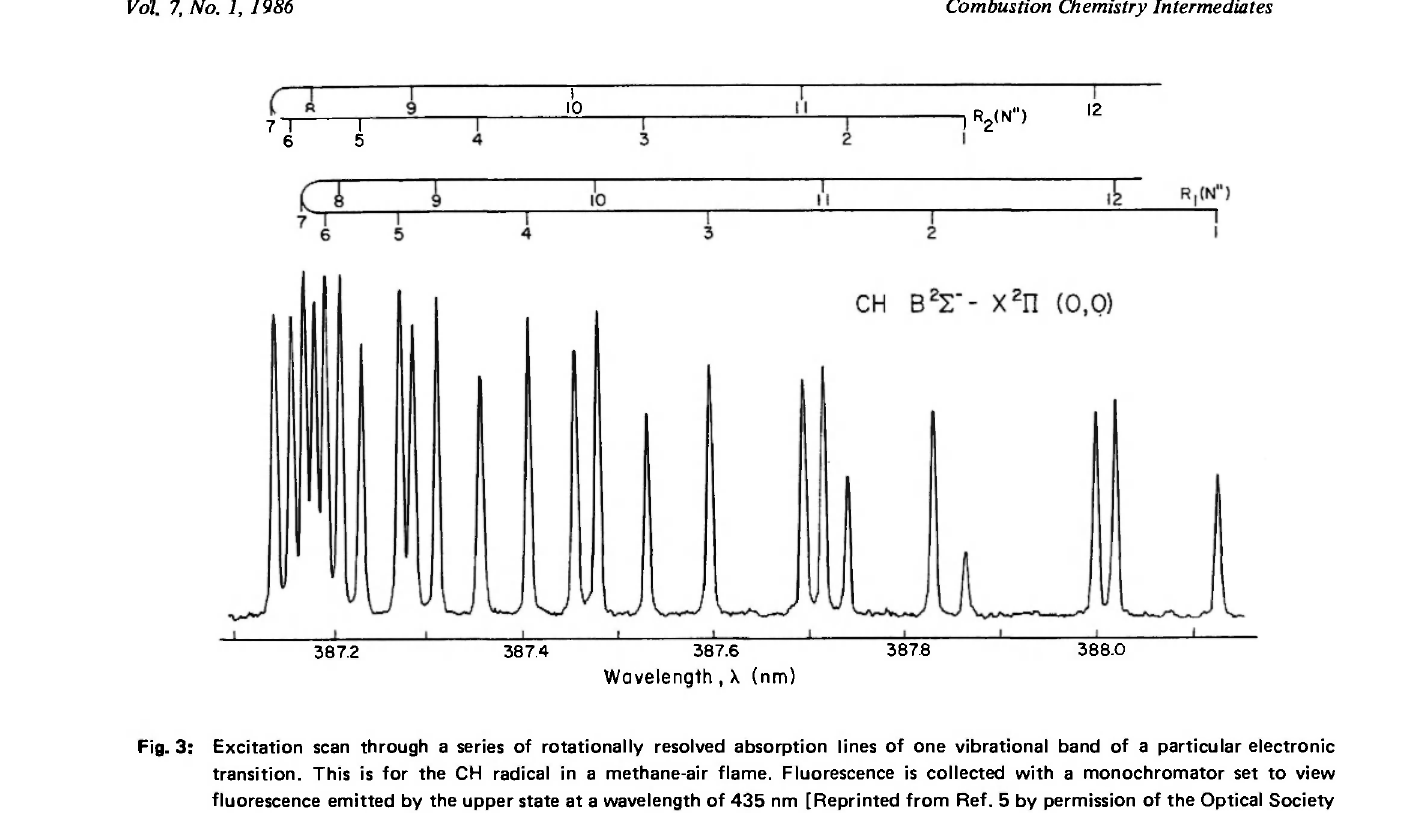
Fig. 3: Excitation scan through a series of rotationally resolved absorption lines of one vibrational band of a particular electronic transition. This is for the CH radical in a methane-air flame. Fluorescence is collected with a monochromator set to view fluorescence emitted by the upper state at a wavelength of 435 nm [Reprinted from Ref. 5 by permission of the Optical Society of